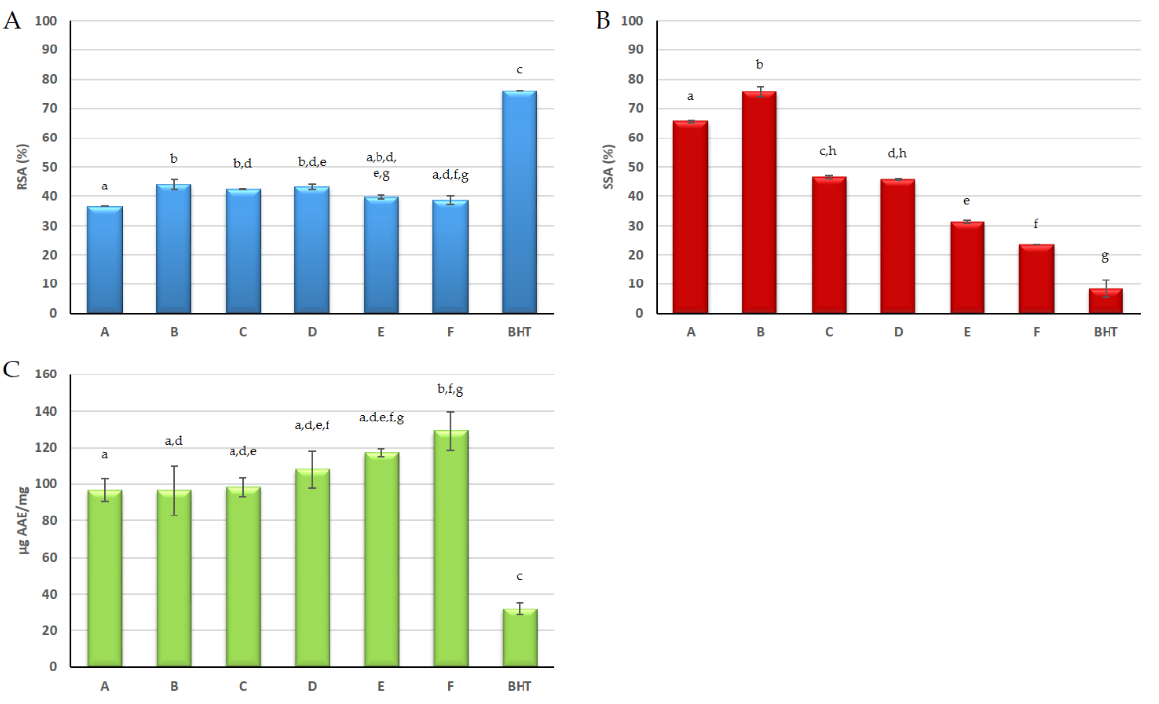
Figure 2. Antioxidant power of OOD extracts prepared by Method 3. Radical Scavenging Activity—RSA ( A ), Superoxide Scavenging Activity—SSA ( B ), Ferric Reducing Antioxidant Power ( C ). BHT: butylatedhydroxytoluene; AAE: Ascorbic Acid Equivalents. Bars with the same letter indicate not significant differences at p > 0.05.